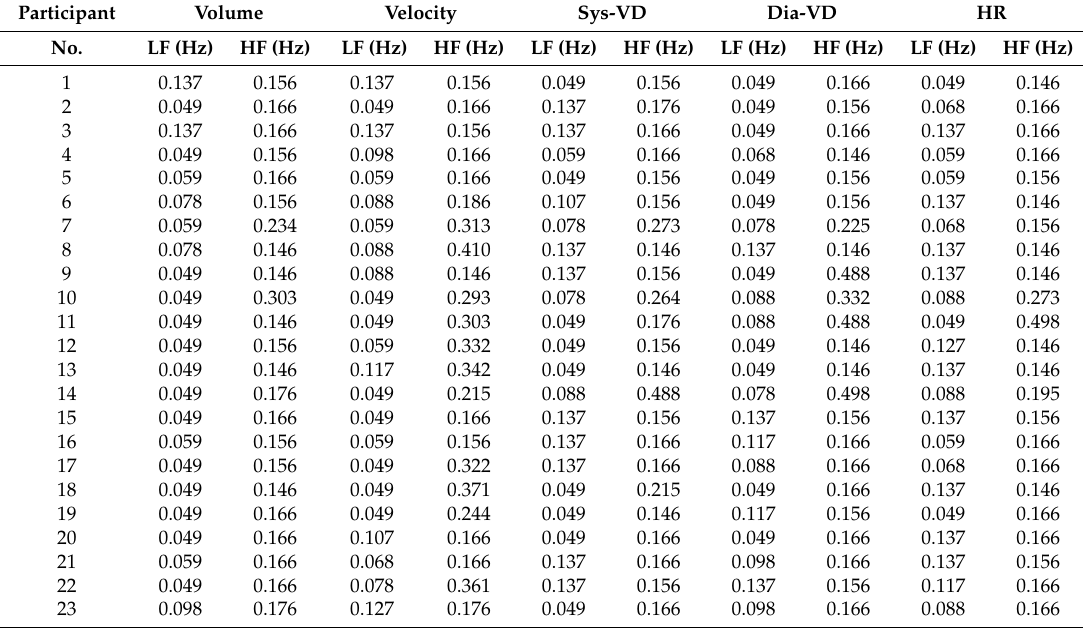
Table 2. Center frequencies (Hz) and low frequency (LF)/high frequency (HF) ratio in the LF